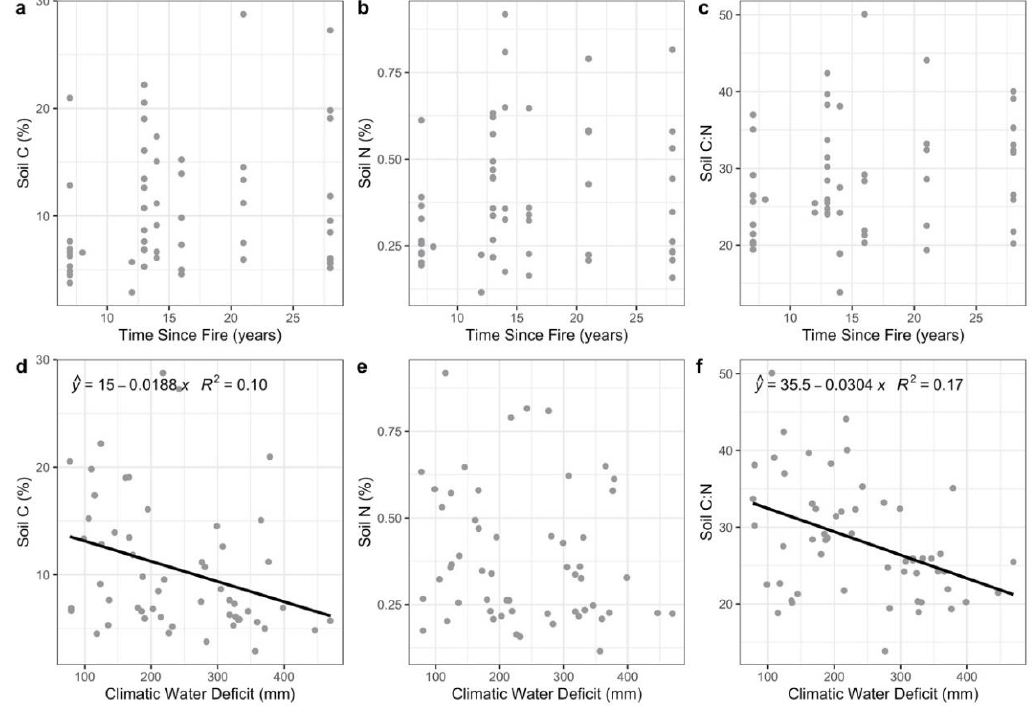
Figure 4. Relationships of soil C, N, and C:N with time since fire ( a - c ) and climatic water deficit ( d - f ). Lines in ( d ) and ( f ) denote significant linear regressions ( p <